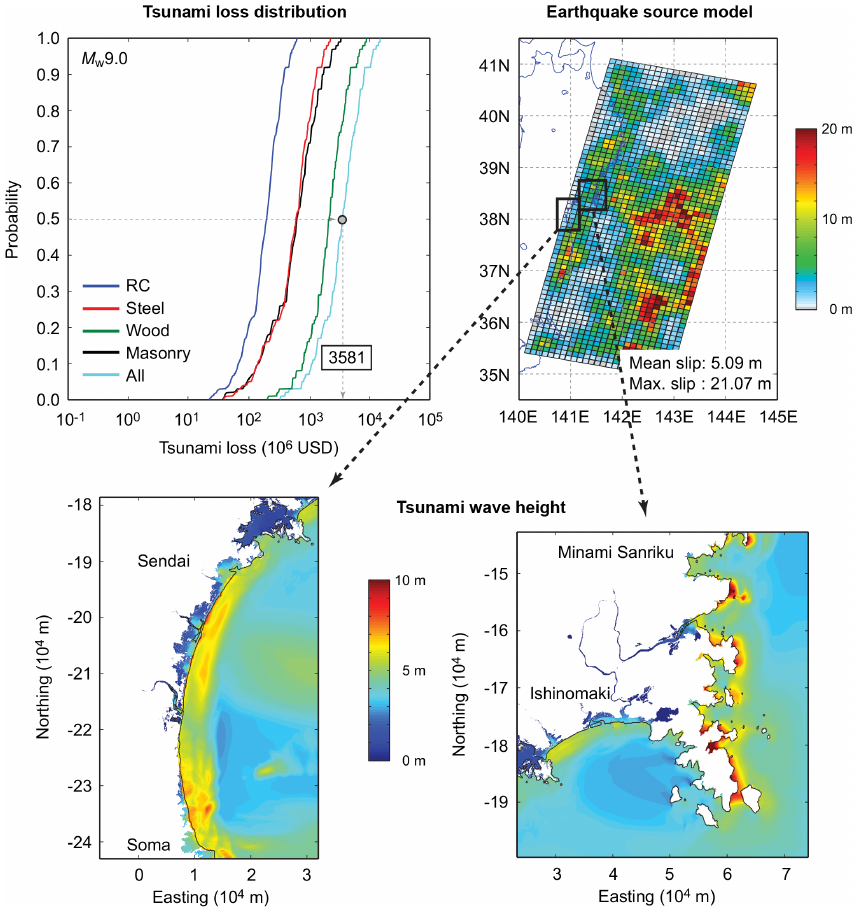
Figure 9. Earthquake source model and inundation height maps that correspond to a critical tsunami loss scenario. For the inundation height maps (bottom two figures), results are shown in the Japanese plane orthogonal coordinate